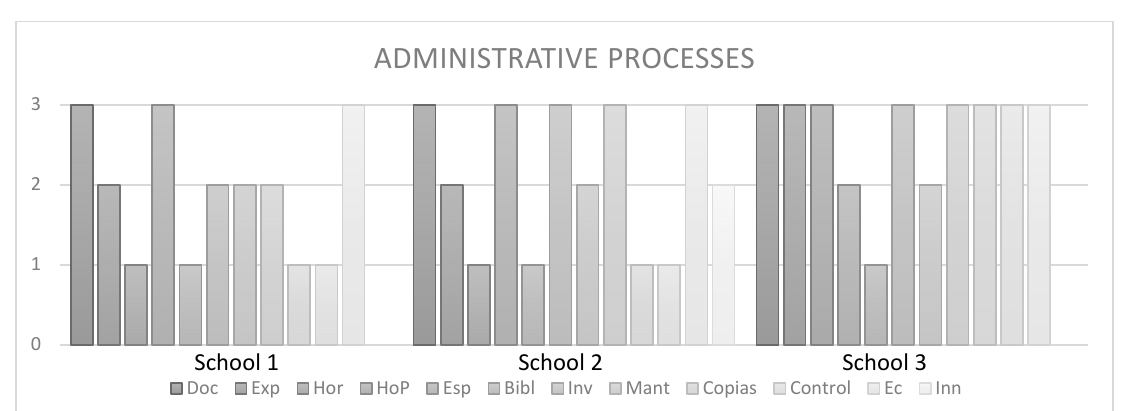
Figure 4. Administrative Processes. Source: author.